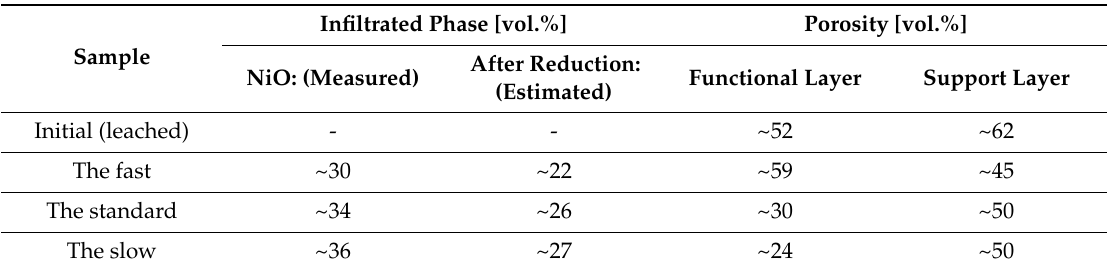
Table 1. Porosity values determined for the studied samples (based on SEM images analysis).